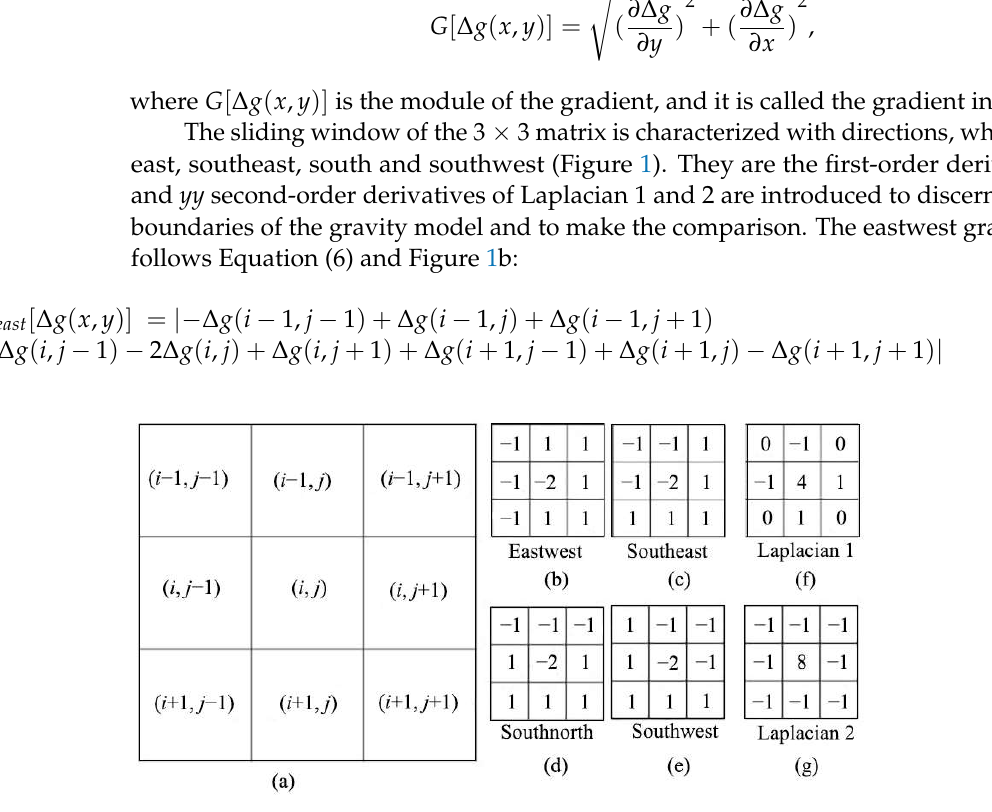
Figure 1. Operator model for the directional gradient filter and the second–order derivate filters of Laplacian 1 and 2. ( a ) The sliding window of 3 × 3 matrix calculation; ( b ) the eastwest gradient filters; ( c ) the southeast gradient filters; ( d ) the southnorth gradient filters; ( e ) the southwest gradient filters; ( f ) the second − order derivate filters of Laplacian 1; ( g ) the second-order derivate filters of Laplacian